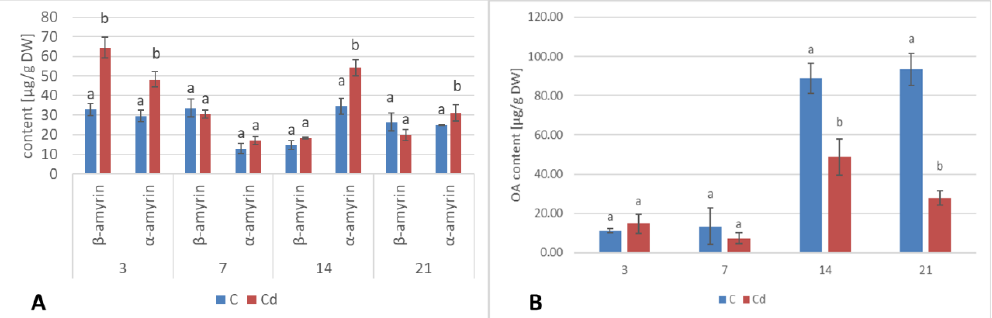
Figure 9. The effect of cadmium treatment on the content of neutral triterpenoids (amyrins) ( A ) and free oleanolic acid (OA) ( B ) in hairy roots tissue. Bars which do not share a common letter are significantly different ( p < 0.05).